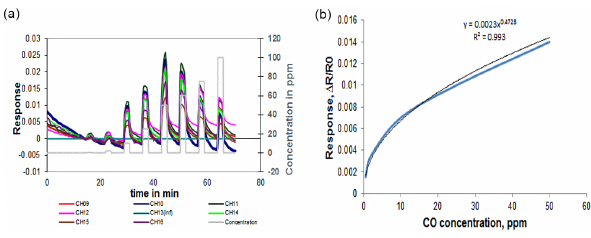
Figure 4. Raman spectra of pristine and sulfonated SWCNTs. Figure 5. (a) Sensor response to exposure of various dosages of CO and (b) the sensor calibration